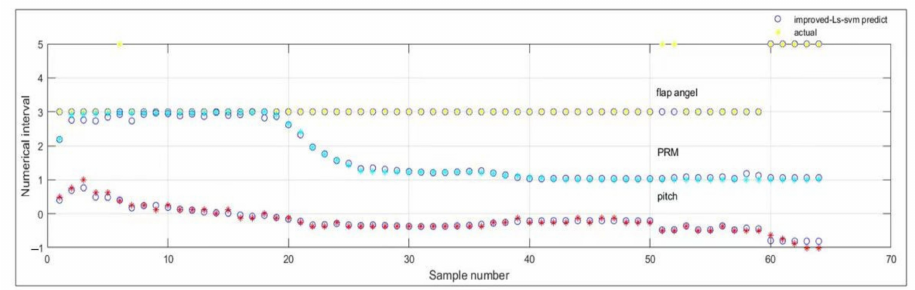
Figure 6. Approach phase simulation diagram.